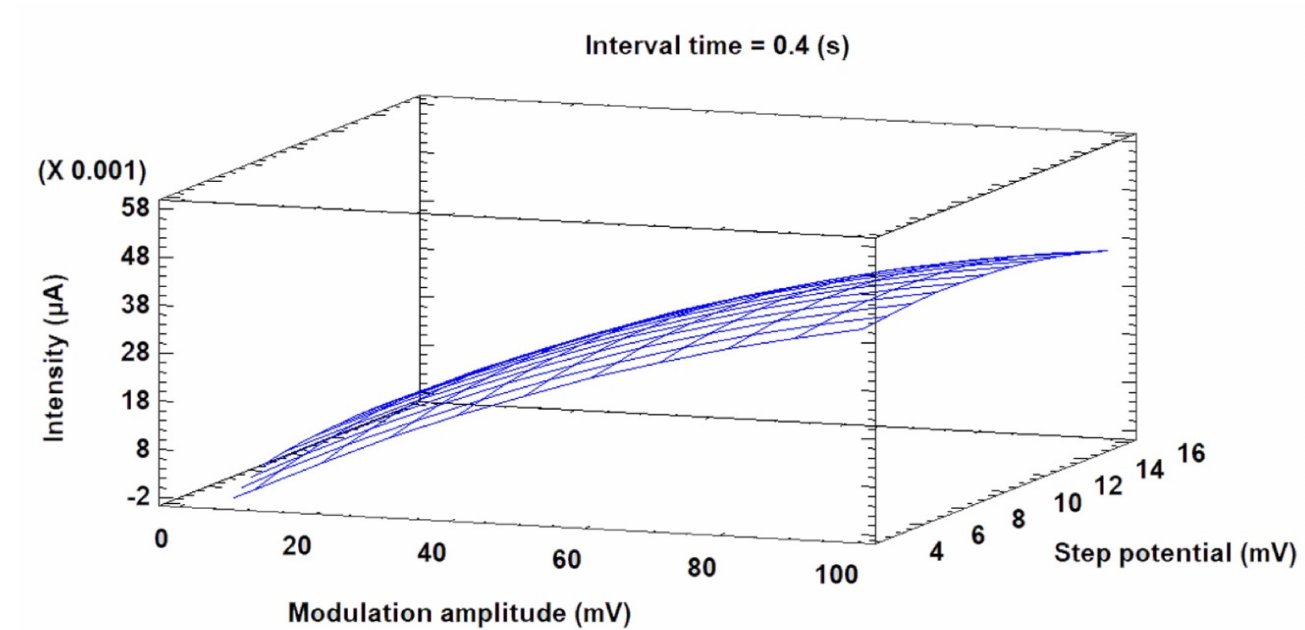
Figure 3. Surface plot of current response.